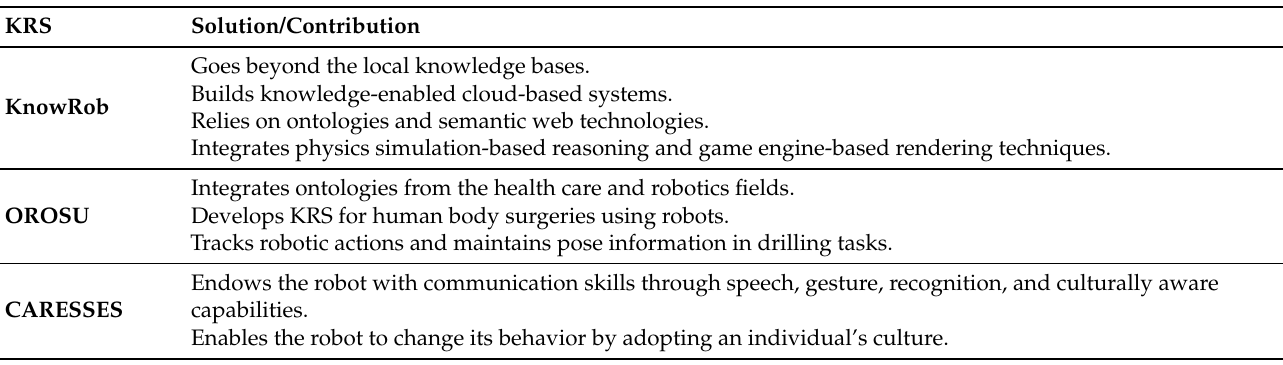
Table 4. KRSs: idea and